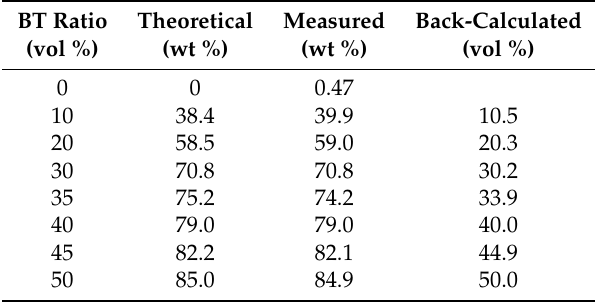
Table 2. Mass ratios obtained after thermogravimetry compared with theoretical values. BT Ratio Theoretical Measured